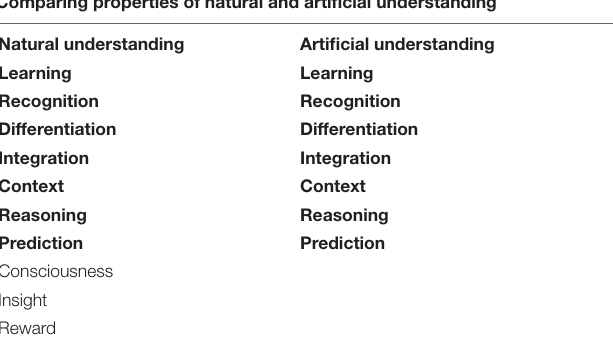
TABLE 4 | Comparison between the key properties of natural and artificial understanding based on the cases discussed above.